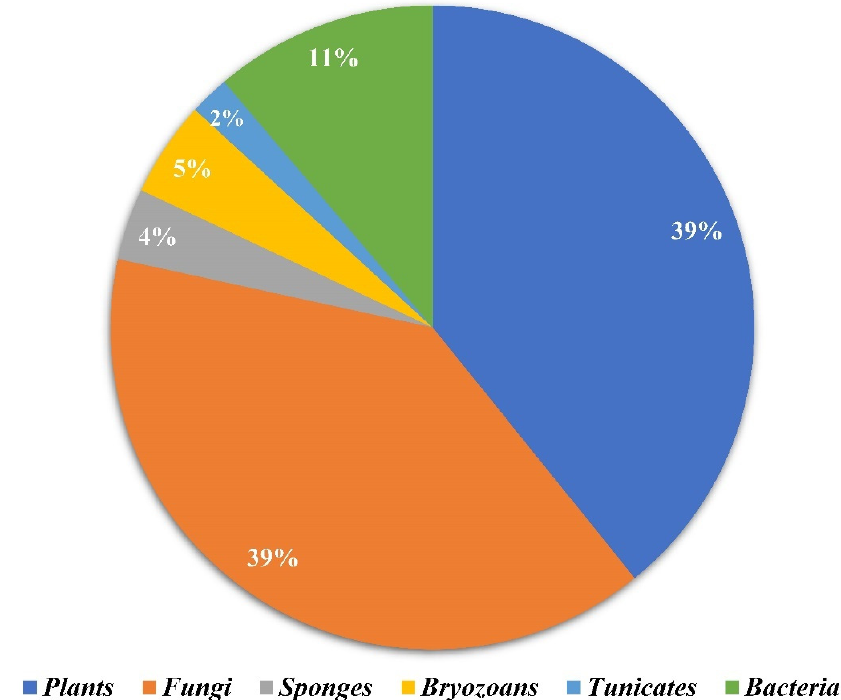
Figure 1. Distribution of the sources of novel indole alkaloids.